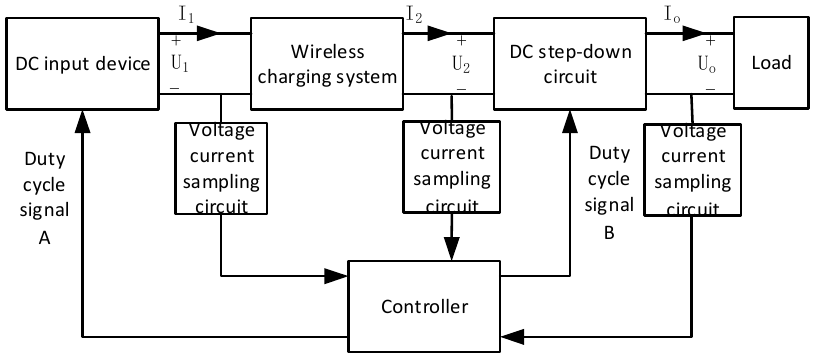
Figure 5. Hardware schematic diagram of load adaptive control strategy.